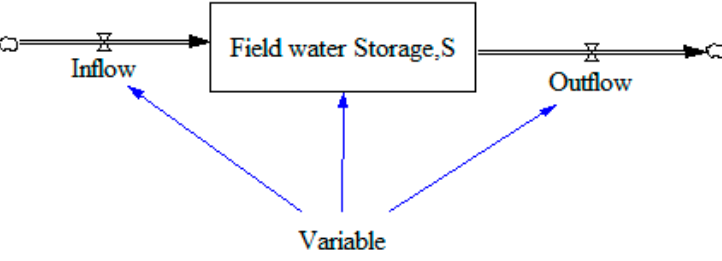
Figure 7. Connection of components of the system dynamic model. Table 4. Component definition of the system dynamic model.